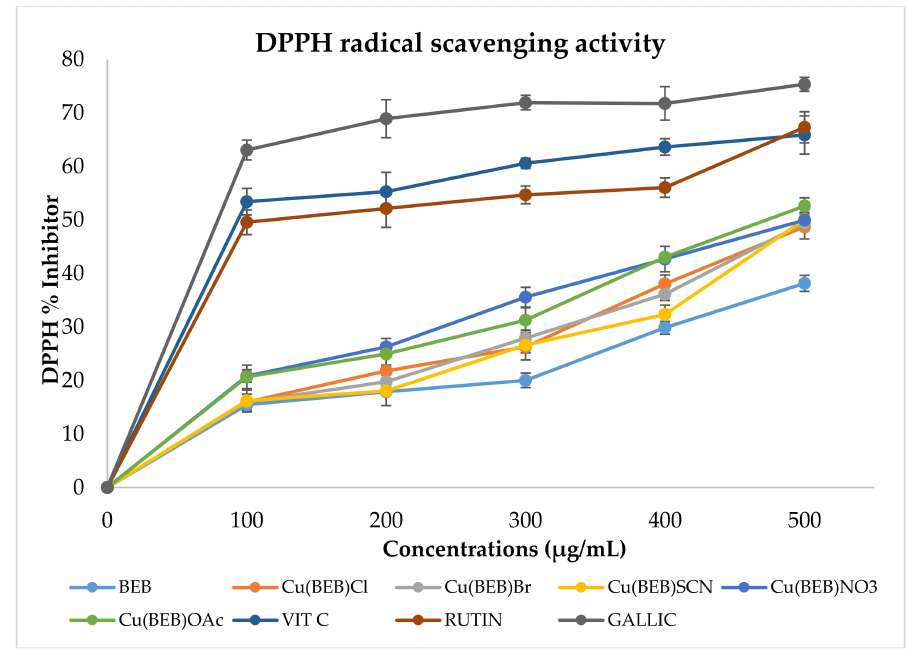
Figure 5. DPPH free radical scavenging assays of BEB and its Cu(II) complexes (n =